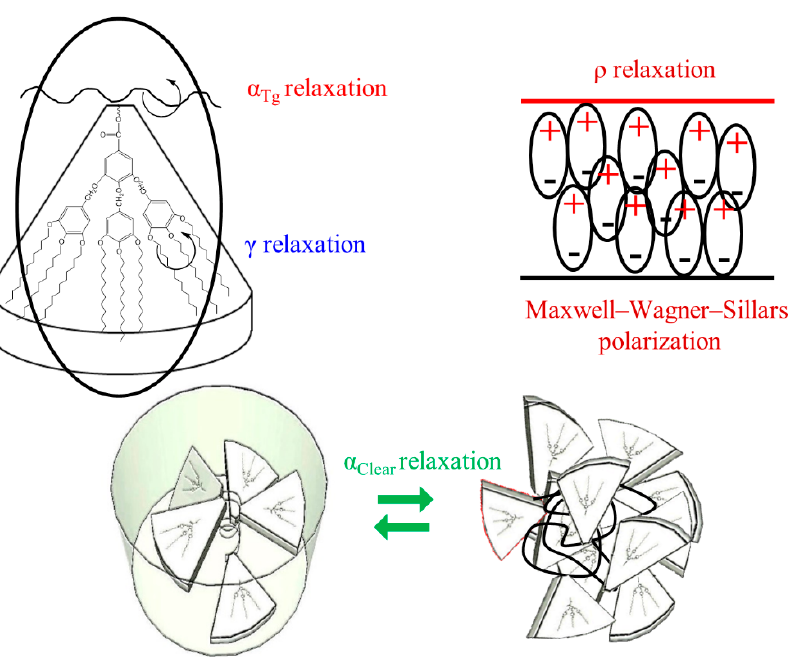
Figure 14. Molecular origin of the different relaxations in PAZE polymer or copolymer. On the other hand, the complexity of the observed relaxations in DETA is also observed by solid-state NMR. Actually, variable temperature 13 C CP-MAS NMR results indicate, that larger molecular reorientations at the polymer main chain as well as the inner phenyl ring of the dendron are initiated in the same temperature range. This temperature range, where dynamic processes of the polymer main chain are activated, seems to be narrower for PAZE100 as compared to PAZE40, where the motional reduction of the broad polymer main chain signals is a gradual process starting already at a significantly lower temperature. We tried to elucidate the nature of the molecular motions involved in the relaxations of PAZE100 between 240 and 340 K. Figure 15 shows the temperature dependence of some protonated phenyl sites at the inner and outer phenyl rings as well as the main chain region of [13] 13 C CP-MAS NMR spectra of